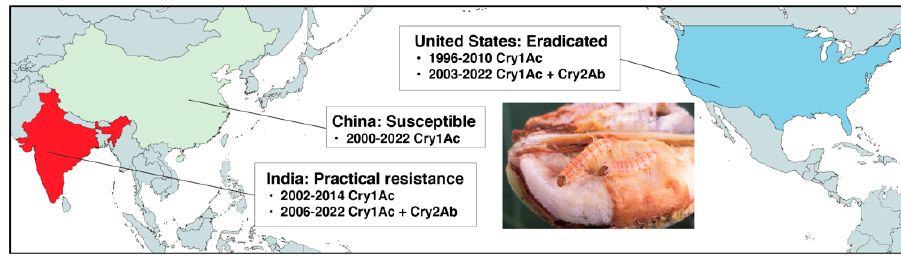
Figure 1. Pink bollworm responses to Bt cotton in the U.S., China, and India. Sustained susceptibility to Bt cotton producing either Cry1Ac or Cry1Ac + Cry2Ab was essential for the success of a multi- tactic program that eradicated pink bollworm from the U.S. [13]. In China, a small increase in re- sistance to Cry1Ac detected during 2008–2010 was reversed following extensive planting of F 2 hy- brid cotton produced by crossing non-Bt cotton with Bt cotton [44]. Pink bollworm evolved practical resistance to Bt cotton producing Cry1Ac and Cry1Ac + Cry2Ab in India, where refuges of non-Bt cotton were scarce [45].